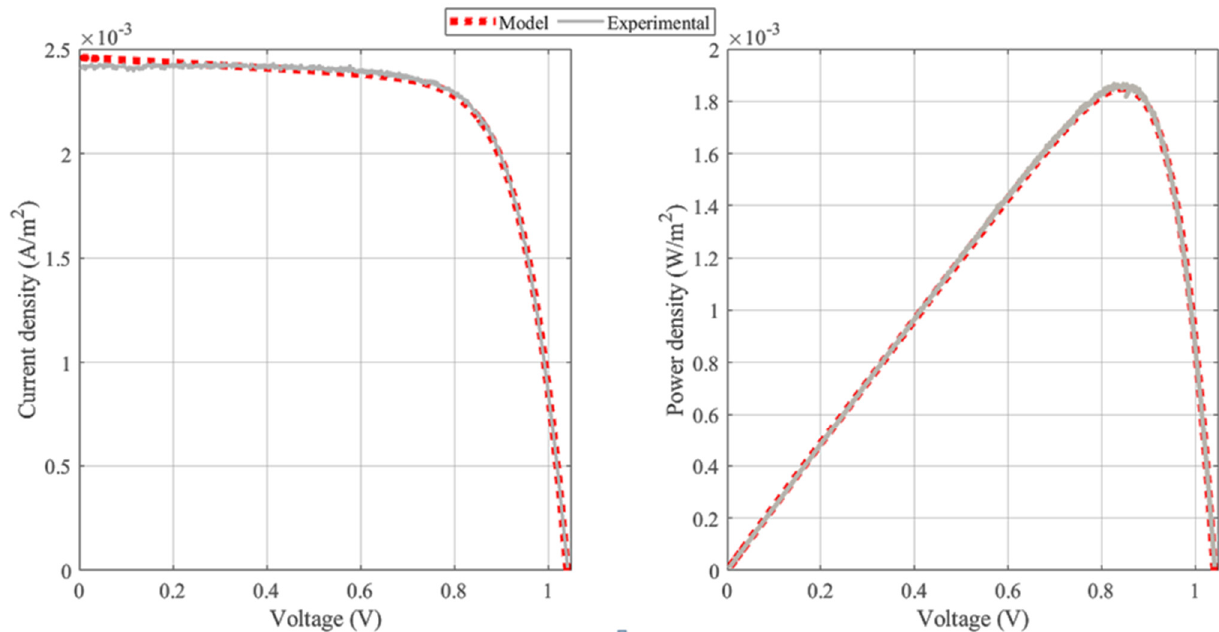
Figure 4. Output characteristic of modified PSC using mBES optimizer.